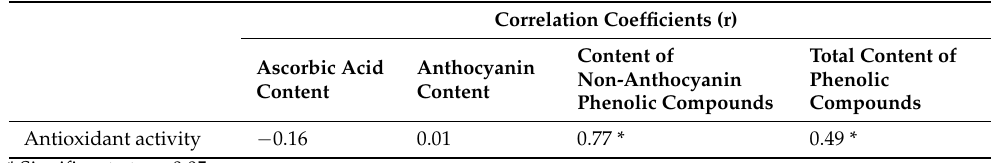
Figure 3. Effect of mash treatment on antioxidant activity (data are means ± standard deviation; the different letters (a–c) indicate a significant difference at p < 0.05 for analysis of variance (ANOVA) and post-hoc analysis performed with Tukey’s test). Table 3. Pearson’s correlation